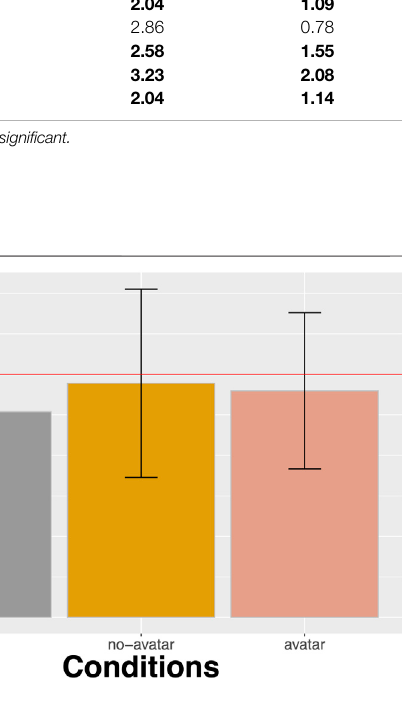
FIGURE 6 | Waiting time duration estimation per condition, with standard deviation bars. Red line indicates objective waiting time.